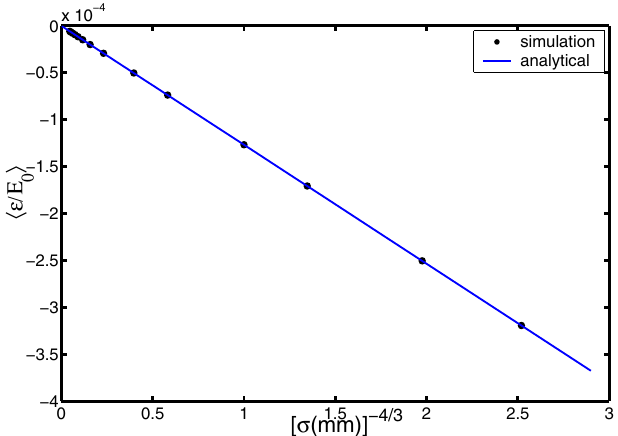
FIG. 3. (Color) Mean fractional energy offset as a function of the bunch length, in the case of a Gaussian bunch with Q (cid:3) 1 nC (cid:3) 1 m and (cid:4) (cid:3) 0 : 34 m . after a dipole with L b